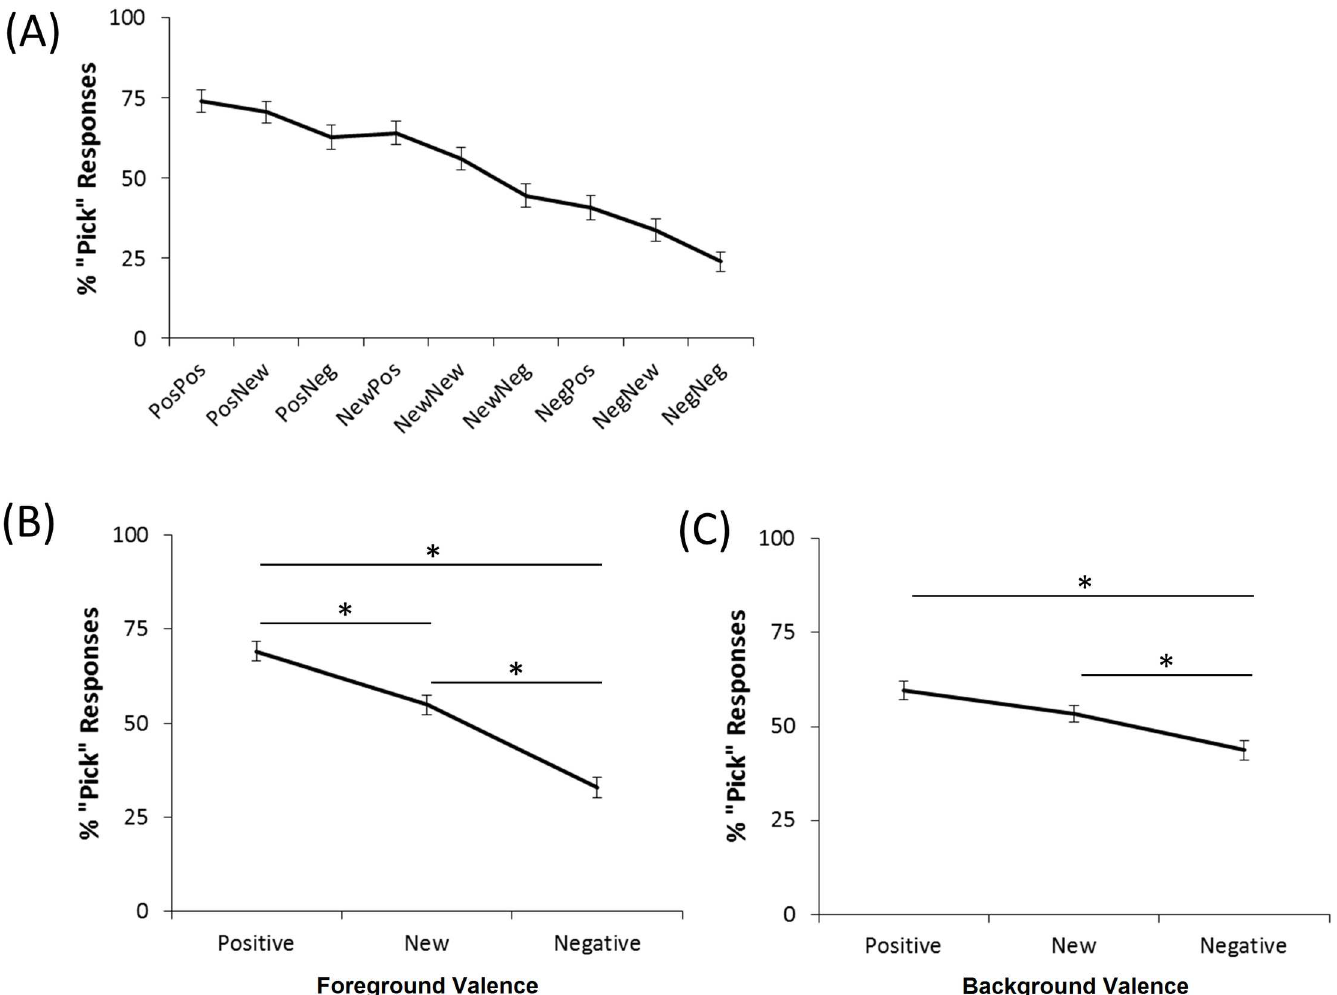
Fig 5. Results from the testing phase of the generalization task. (A) Participant responding,indexedas percent “pick” responses over the three trials with each test stimulus, was modulated both by foreground and backgroundvalence.Labelsalong the x-axes are of the form “foreground-background” indicatingwhetherthe foregroundor background was positive (“Pos”), previously negative(“Neg”) or New. For example,“PosPos” indicates a positive foregroundpairedwith a positive background, while“PosNew” indicatesa positive foregroundpairedwith a new background that was not experienced duringthe trainingphase. (B) Respondingwas modulated by foregroundvalence,with more “pick” responses to stimuli with positive than new foregrounds, regardlessof background. Both positive and new foregrounds were picked more often than negative foregrounds. (C) Similarly, background valence affected respondingwith more “pick” responsesto stimuli with either positive or new backgroundscomparedto those with negativebackgrounds. Asterisks indicate significantwithin-subject differences.